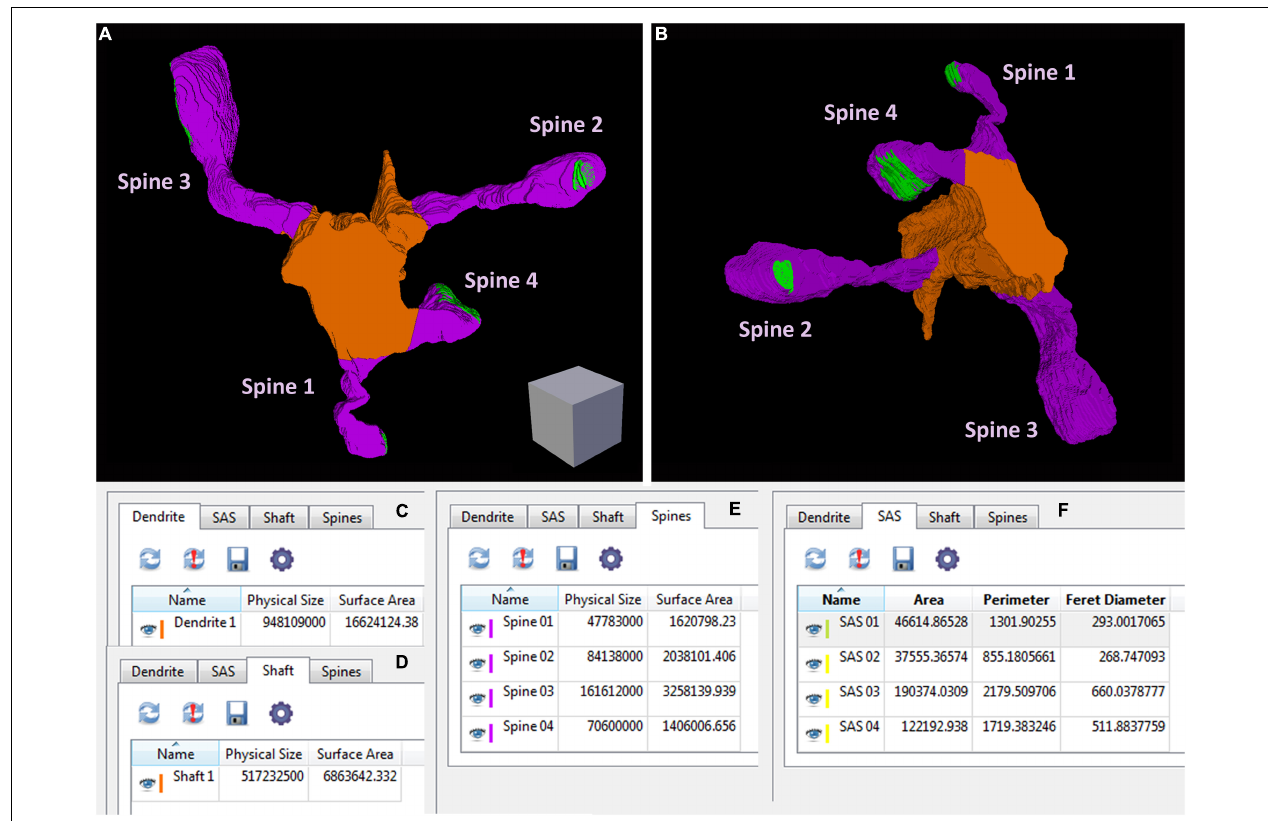
FIGURE 5 | An example of geometric information obtained from a reconstructed dendritic segment and its corresponding dendritic spines and synaptic contacts (see also Supplementary Video 3 ). (A,B) A dendritic segment has been reconstructed with Espina software. Four dendritic spines (purple) arise from the dendritic shaft (orange). The synaptic junctions have been represented in green. Only complete dendritic spines have been represented in this example. In Supplementary Video 3 we have also represented dendritic spines that have been truncated by the edges of the stack. Once the structures have been reconstructed, the software provides different geometric parameters. (C) Espina tab for the total volume of the dendritic segment, indicated as “Physical size” and expressed in cubic nm. In this particular example, the estimation of the total volume comprises the dendritic shaft and all dendritic spines reconstructed as a whole, including spines that have not been represented in this figure but are shown in Supplementary Video 3 . The surface area of the dendrite is expressed in square nm. (D) This tab shows the volume and surface area of the dendritic shaft alone. (E) The volume and surface area of each dendritic spine, reconstructed individually. (F) The area, perimeter and Feret diameter of the synaptic apposition surface, have been calculated for the four synaptic contacts. These and other parameters can be exported by Espina for further analysis (Espina software can be downloaded from https://cajalbbp.es/espina/). Scale cube is 0.5 µ m on each